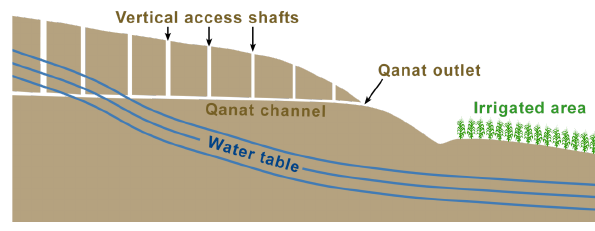
Figure 3. Cartoon cross-section through a typical qanat.